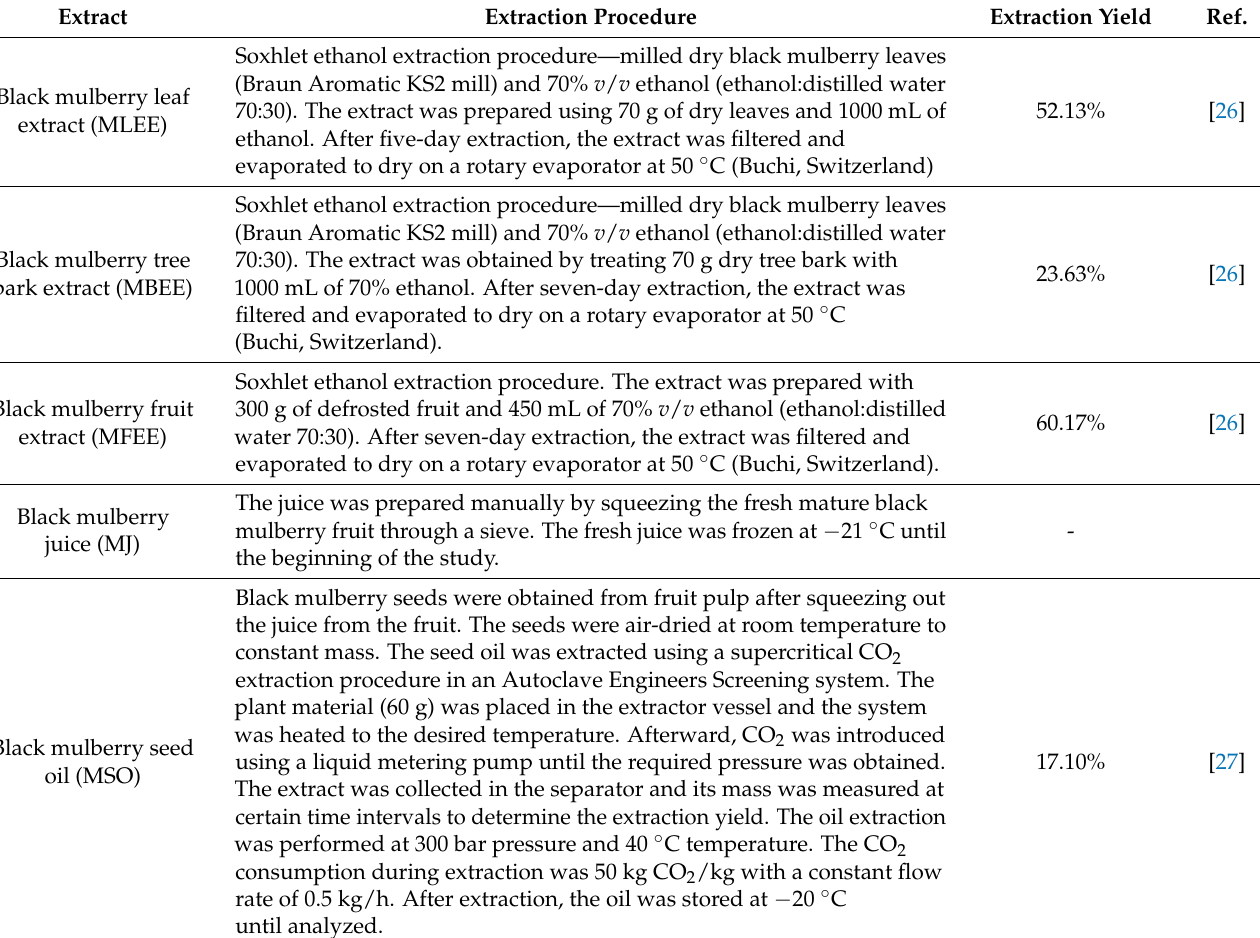
Table 1. Black mulberry extraction